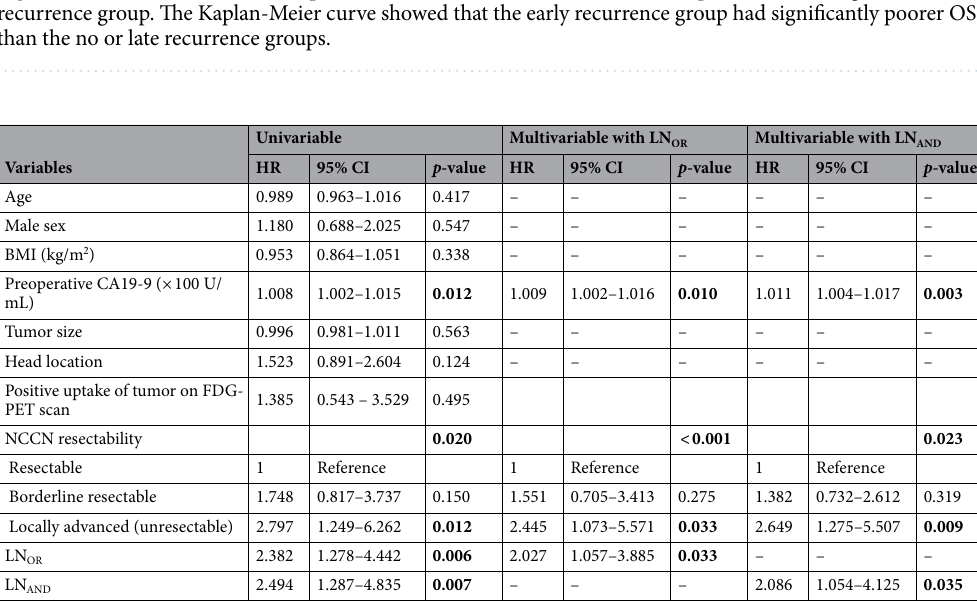
Table 3. Univariable and multivariable Cox proportional hazard analyses between preoperative characteristics and early recurrence. HR, hazard ratio; CI, confidence interval; BMI , body mass index; CA19-9 , carbohydrate antigen 19–9; FDG-PET , 18 F-fluoro-2-deoxyglucose-positron emission tomography; LN OR , regional LN metastasis on preoperative CT or FDG-PET scans; LN AND , regional LN metastasis on preoperative CT and FDG-PET scans; NCCN , National Comprehensive Cancer Network. Significant values are in